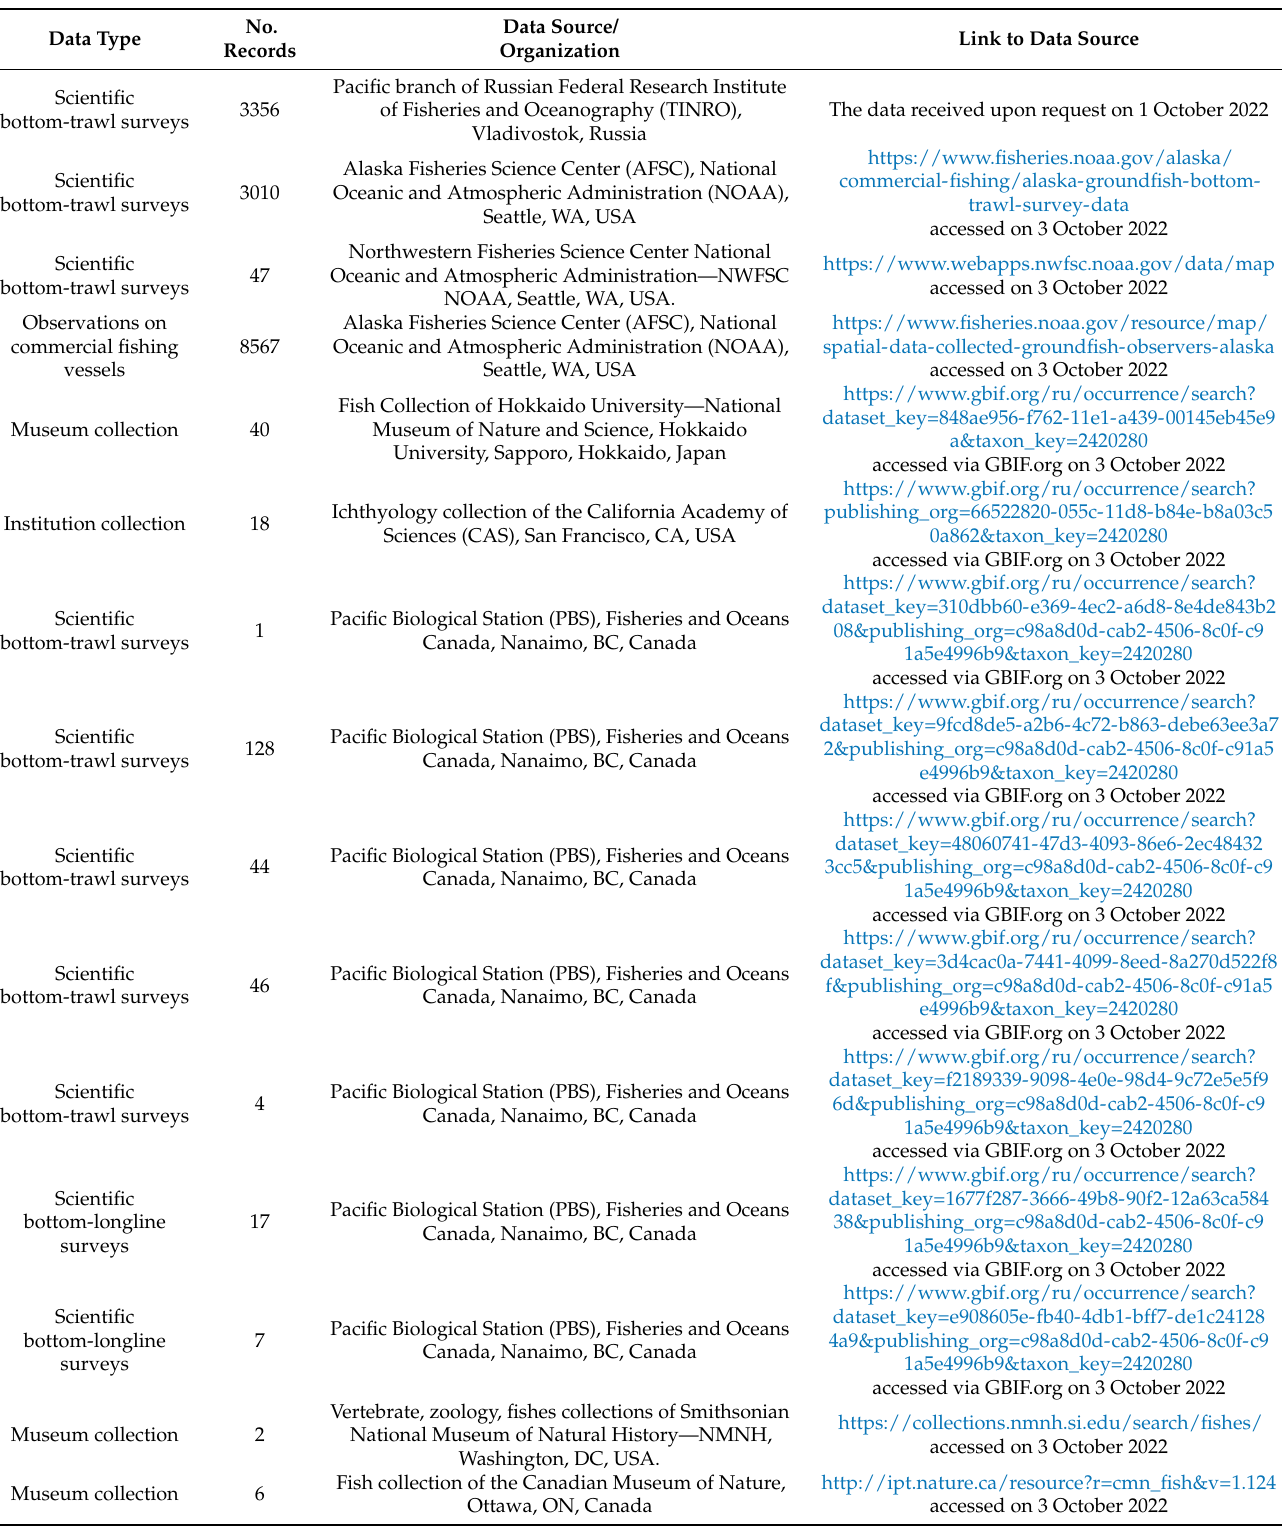
Table 1. Description of the data used for the analysis of spatial and vertical distribution of the Aleutian skate Bathyraja aleutica in the North Pacific,